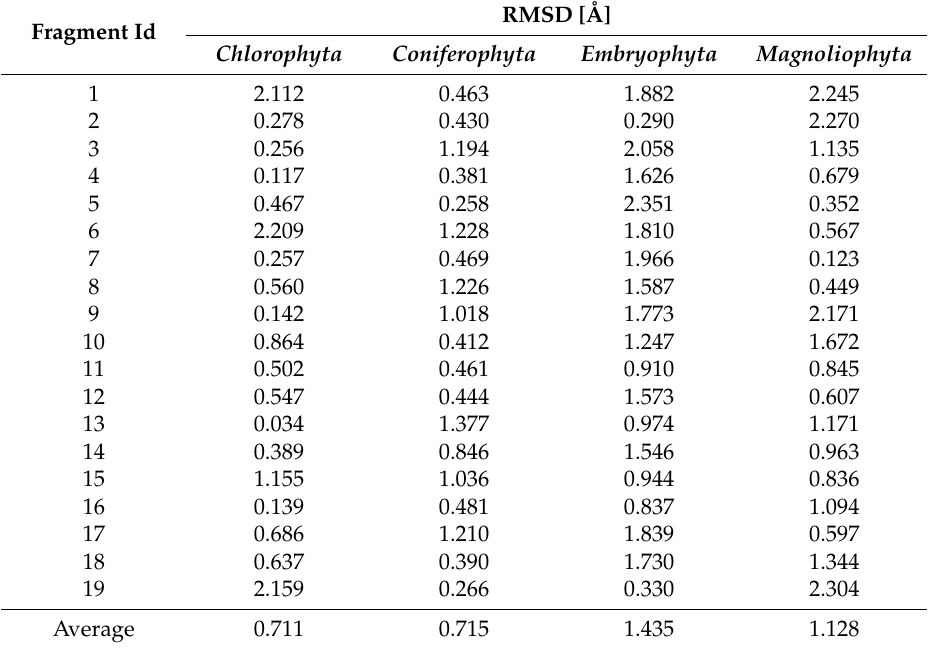
Table 5. RMSD values of 3D fragments from each phylum.